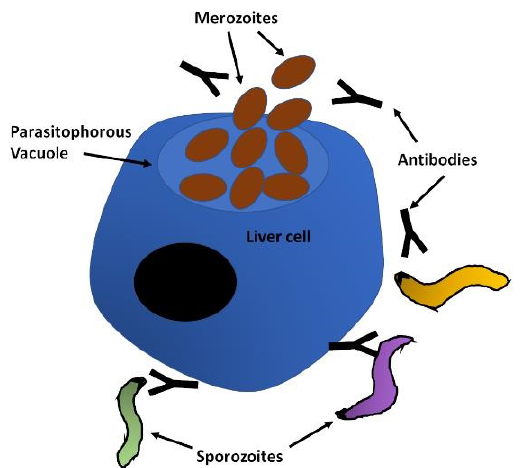
Figure 2. The liver stage. Sporozoites leave the skin and migrate to the liver, where they invade hepatocytes. Surface proteins of the sporozoite are involved in the migration, recognition and invasion of hepatocytes. These are represented by the dense black outline of the sporozoites and increased density in the apical region, and include mainly CSP, TRAP and AMA-1 at this stage. After the intracellular replication of the parasite the first merozoites that will initiate the blood infection are released into the blood stream. Pre-erythrocytic vaccines aim to induce an immune response, humoral and cellular, to interfere with invasion and trigger elimination of the parasite, respectively. CSP (circumsporozoite protein); TRAP (thrombospondin-related anonymous protein); AMA-1 (apical membrane antigen 1).